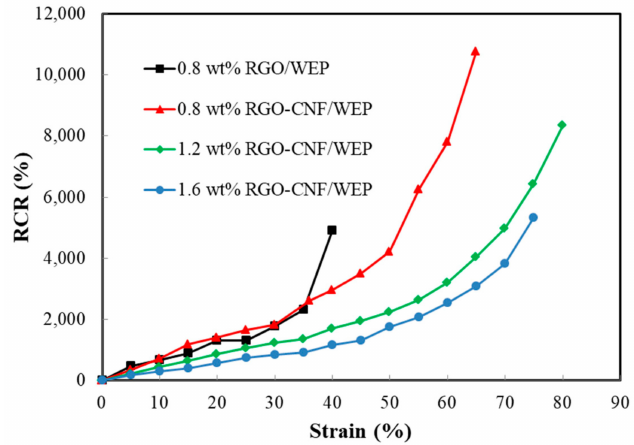
Figure 5. The correlation of the resistance change rate (RCR) and strain of four film